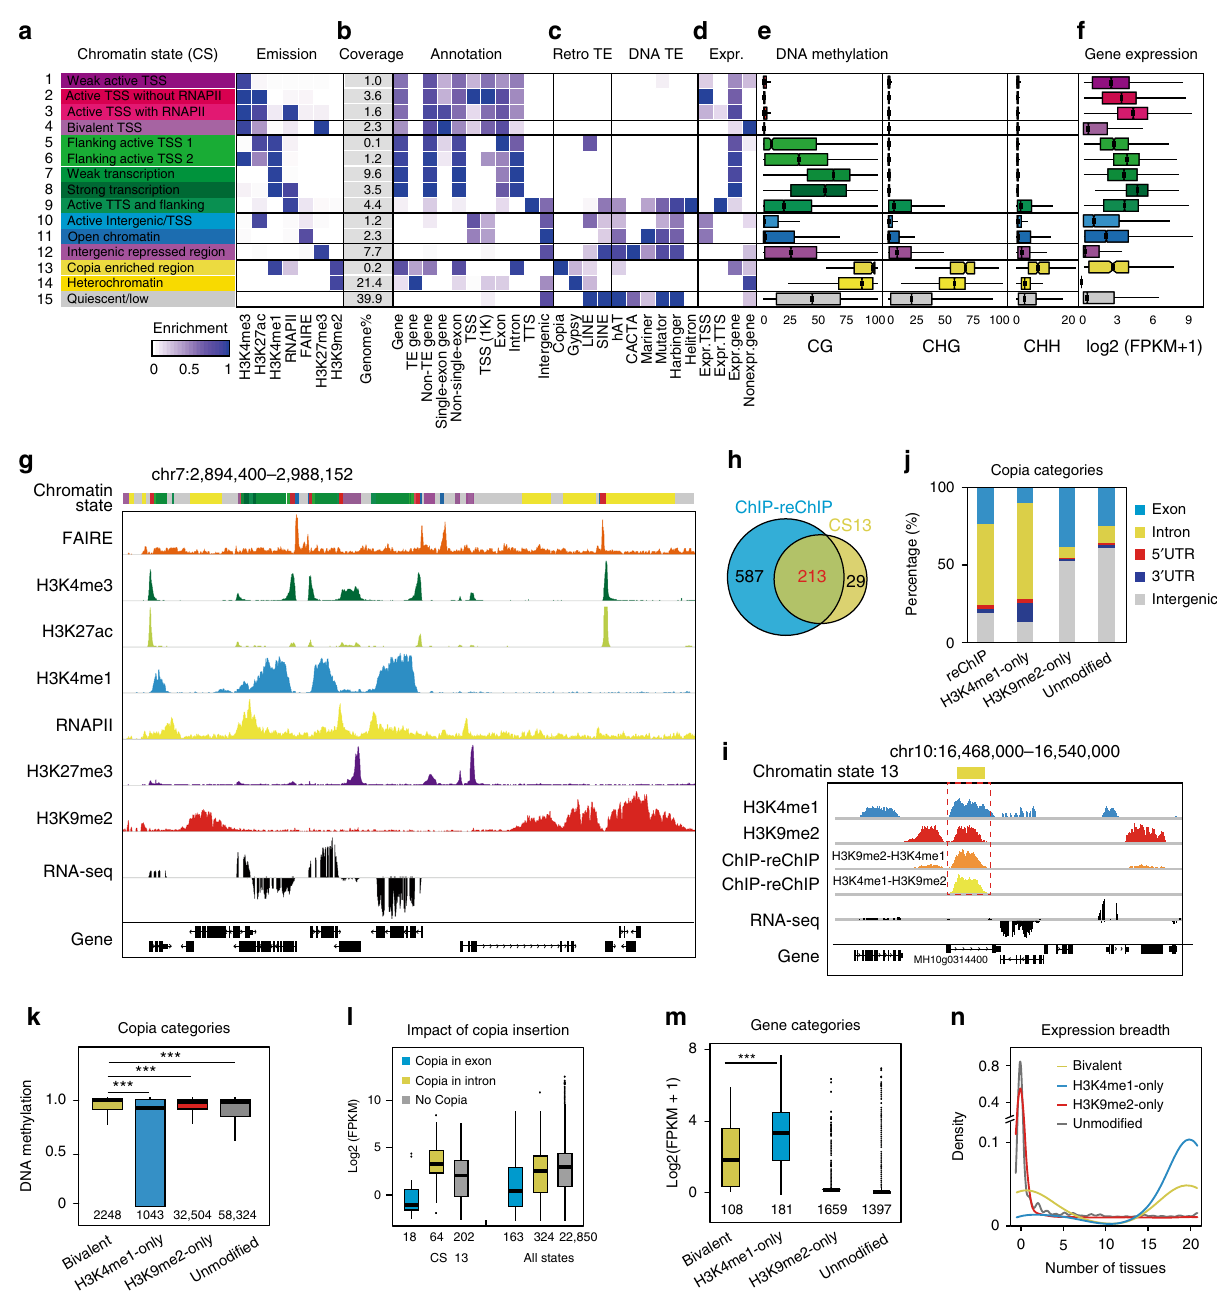
Fig. 2 Comprehensive epigenome map in MH63 young leaf. a Chromatin state de fi nitions, abbreviations, and composition (emission probability) of histone marks, open chromatin (FAIRE), and RNAPII occupancy. b Genome coverage and genomic annotation enrichments. TSS transcription start sites, TTS transcription terminal sites. c TE enrichments. Retrotransposons (retro TE; Copia , Gypsy , LINE and SINE) and DNA transposons (DNA TE; hAT, CACTA, Mariner, Mutator, Harbinger, and Helitron) are shown. d Active and inactive gene enrichments. e Methylation levels at CG, CHG, and CHH sites g Example of chromatin states. State colors are as in ( a ). h Venn diagram showing the overlap of H3K4me1-ChIP/H3K9me2-reChIP binding targets with chromatin state 13 regions. i Genome browser screenshot showing H3K4me1, H3K9me2 eChIP-Seq data and H3K9me2-ChIP/H3K4me1-reChIP-Seq, H3K4me1-ChIP/H3K9me2-reChIP-Seq data for a representative bivalent gene in chromatin state 13. j Distribution of different Copia categories in the indicated regions of the rice genome. Each type of sample number was indicated in ( m ). k DNA methylation levels of Copia in the indicated categories. The numbers indicate the sample size used in the analysis l Density plot of gene expression in chromatin state 13. Genes with Copia in an exon or an intron,